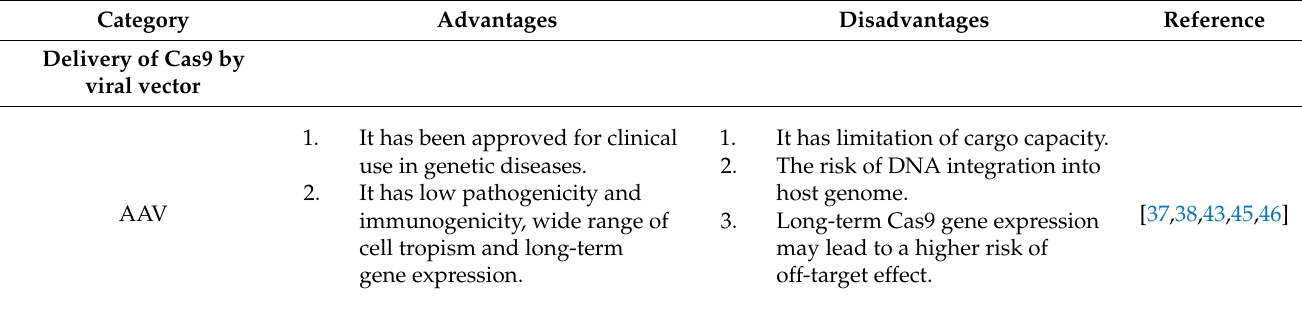
Table 3. Viral and nonviral delivery vectors for studying the effect of CRISPR-Cas9-mediated gene editing on HBV